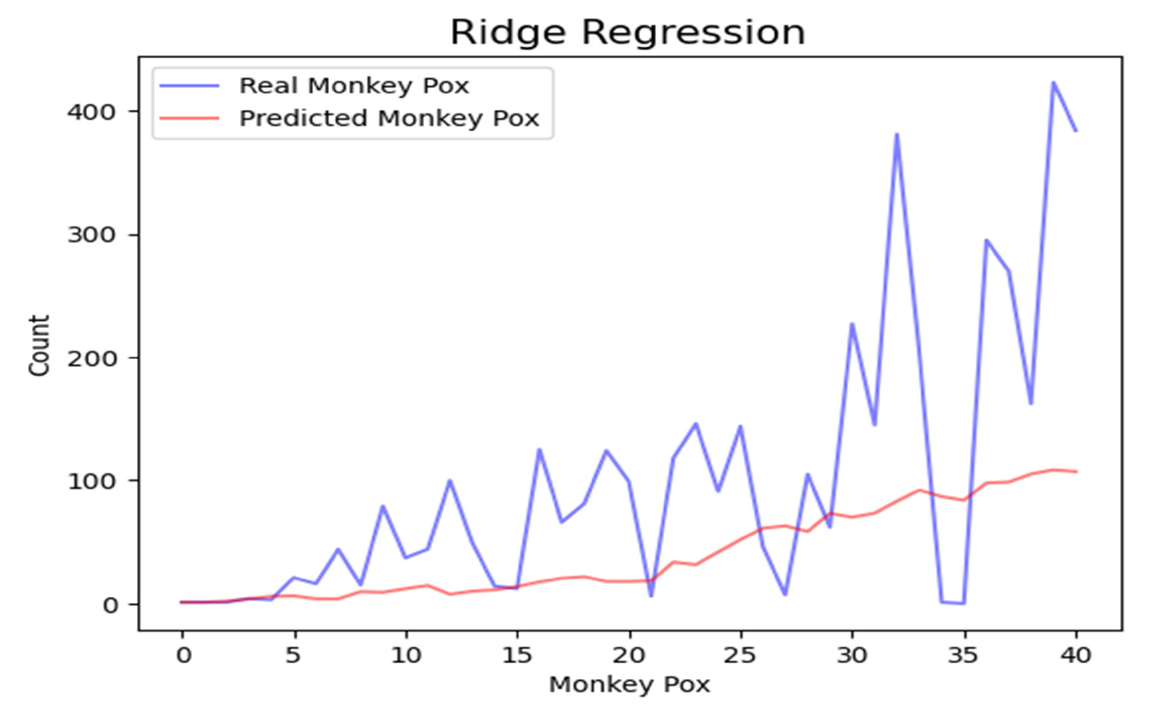
Figure 13. Time Series of Ridge Regression Algorithm.